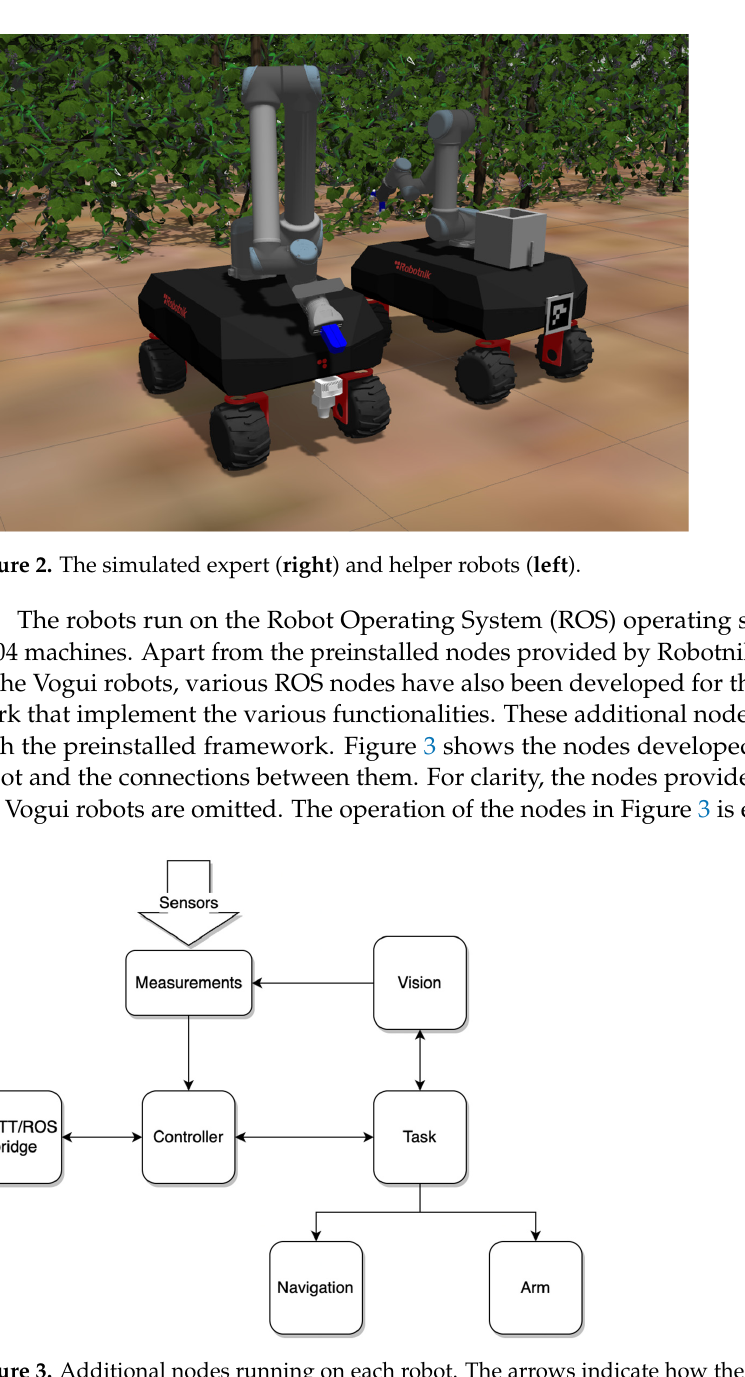
Figure 3. Additional nodes running on each robot. The arrows indicate how the nodes communicate with each other.